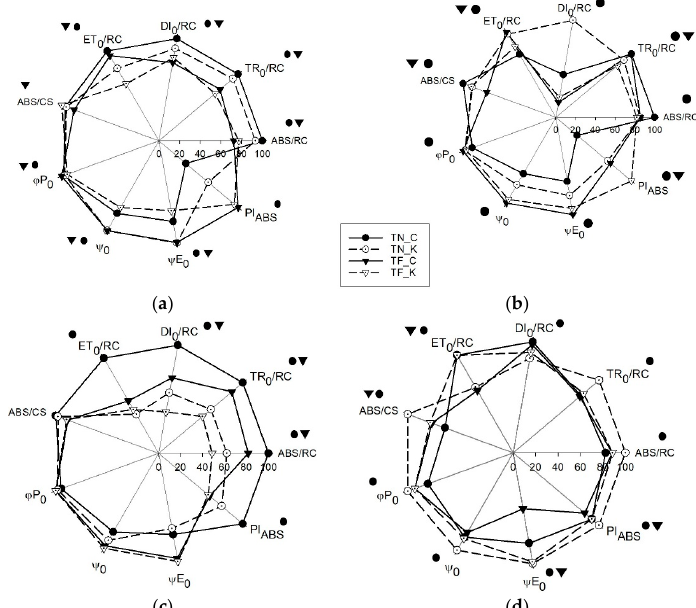
Figure 3. Radar plots of JIP parameters deduced from chlorophyll a fluorescence OJIP transients in the grapevine leaves of Touriga Nacional control (TN_C) and kaolin (TN_C), and Touriga Franca control (TF_C) and kaolin (TF_K) in the Douro site at stages EL35 and EL38 of 2017 ( a , b ) and 2018 ( c , d ). Data are mean ± SD ( n = 18). For each parameter, the lower value represents relative change against the maximum value, set as 100%. Closed circles ( ⬤ ) and triangles ( ⯆ ) at the top of each parameter represent significant differences between treatments in Touriga Nacional and Touriga Franca, respectively.